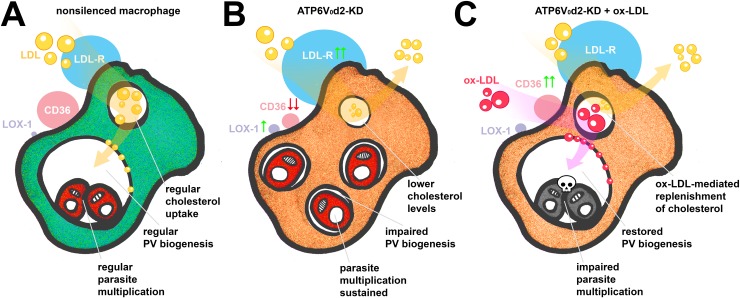
Mechanistic model proposed for the participation of V-ATPase subunit ATP6V0d isoform d2 in the macrophage intracellular cholesterol regulation and L. amazonensis PV biogenesis.A. The parasite upregulates the expression of d2 subunit (ATP6V0d2) but not the regular and ubiquitous d1 isoform, ATP6V0d1, indicating that infection is accompanied by additional functions of V-ATPases not necessarily related to acidification. Infection and PV biogenesis do not disturb the expression of cholesterol biosynthesis regulator SREBP2 nor the expression of scavenger receptors for nonmodified (LDL-R) or modified forms of LDL (Msr1/SRA, CD36, LOX-1) in nonsilenced macrophages. B. ATP6V0d2-KD macrophages presented 40% depletion in intracellular cholesterol levels that, although not interfering in parasite multiplication (which main sterol component is ergosterol), severely impaired L. amazonensis PV enlargement. CD36 expression is decreased during ATP6V0d2 knock-down and, with decreased levels of intracellular cholesterol, LDL-R expression is increased. LOX-1 and SRA expression suggests that modified LDL are able to be captured by infected cells despite ATP6V0d2 knock-down and CD36 decreased expression. C. When ATP6V0d2-KD macrophage intracellular cholesterol is replenished with exogenous oxidized Low-Density Lipoprotein (ox-LDL), a parasite-mediated restoration of CD36 expression is observed together with restored PV volumes. The ox-LDL source of cholesterol incorporated by ATP6V0d2-KD macrophages accumulated in PVs impaired parasite multiplication despite recovering PV dimensions.